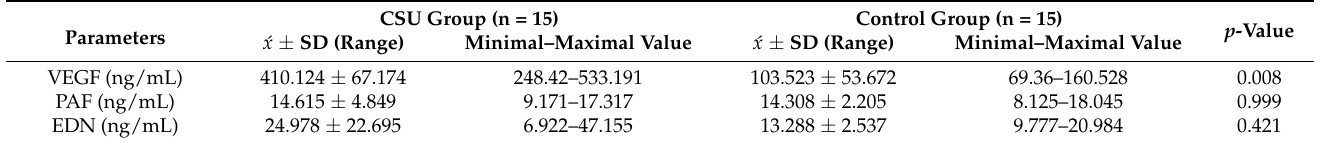
Table 1. Laboratory findings in the examined participants.